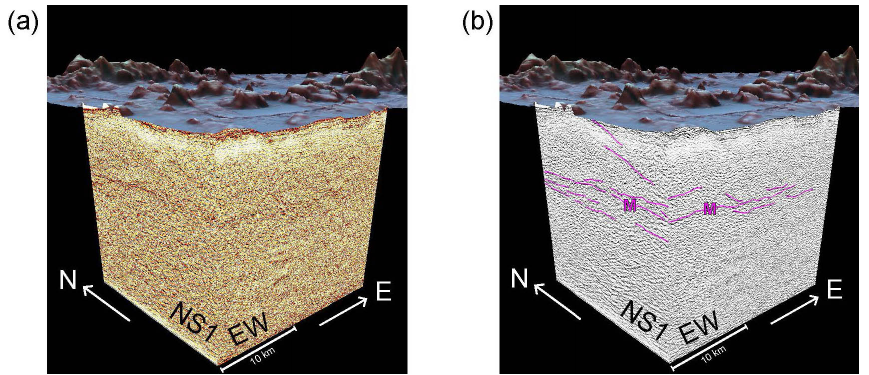
Figure 5. Three-dimensional view from the southwest to the northeast around the OBS1. (a) Prestack time-migrated section. (b) Reflector interpretation. M denotes the Moho reflection.